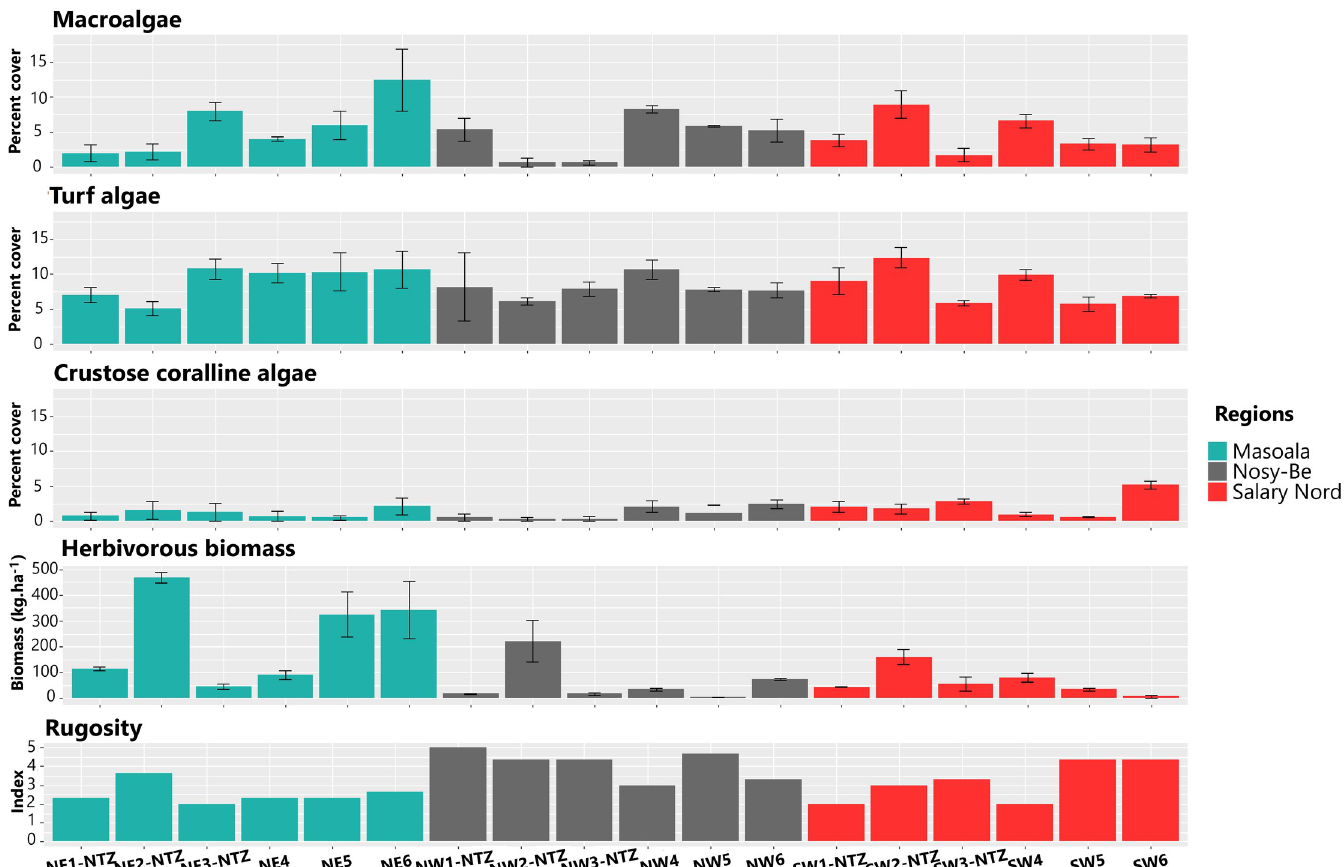
Fig 3. Spatial variation of explanatory variables that may influence the spatial variation of coral assemblages. Data are given for the 18 sampling stations located at the three regions. Errors bars represent standard error.